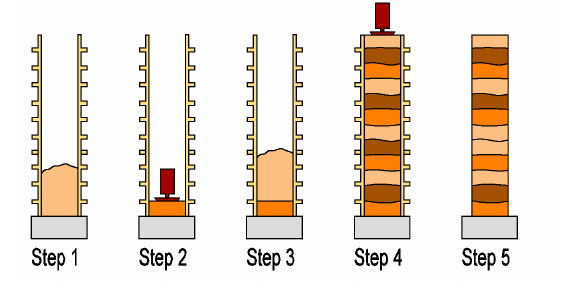
Figure 1. The process of building rammed earth